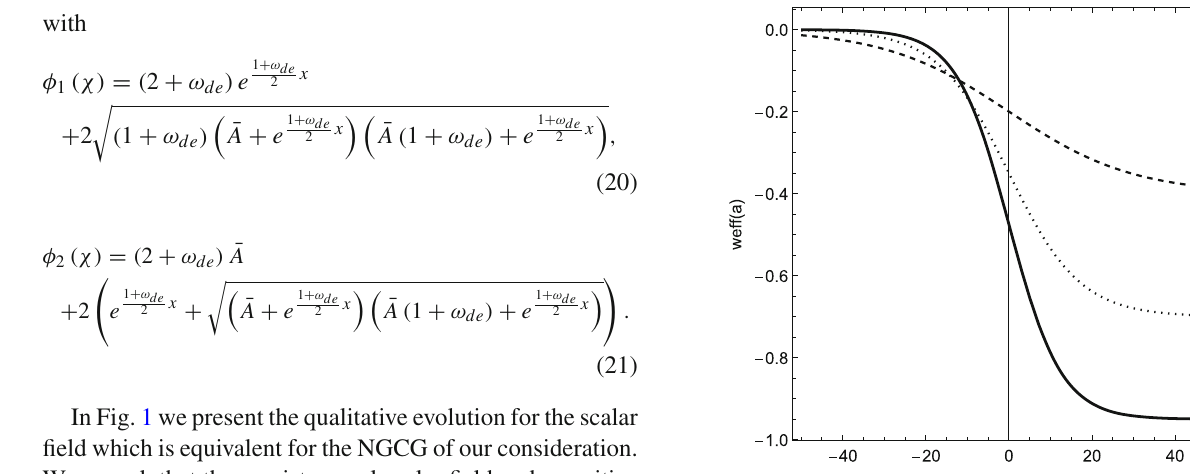
= − 0 . 5. Right figure is the parametric plot de